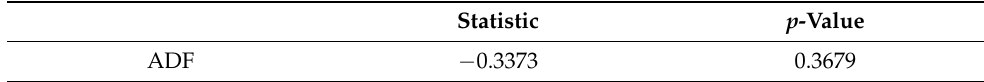
Table 2. Kao panel cointegration test.